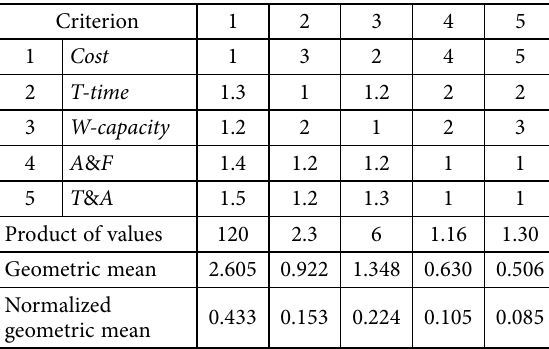
Table 3. Values obtained using the Saaty’s method